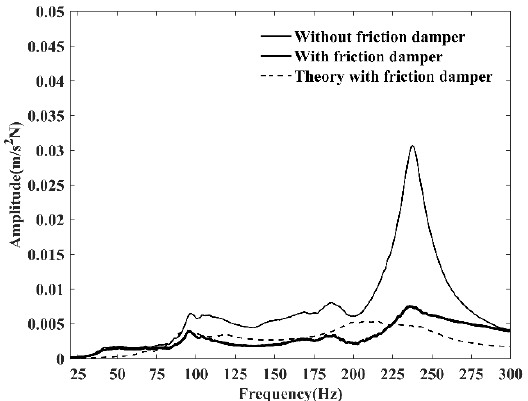
Figure 17. Comparison of experimental AFRF of thrust bearing with and without friction damper.